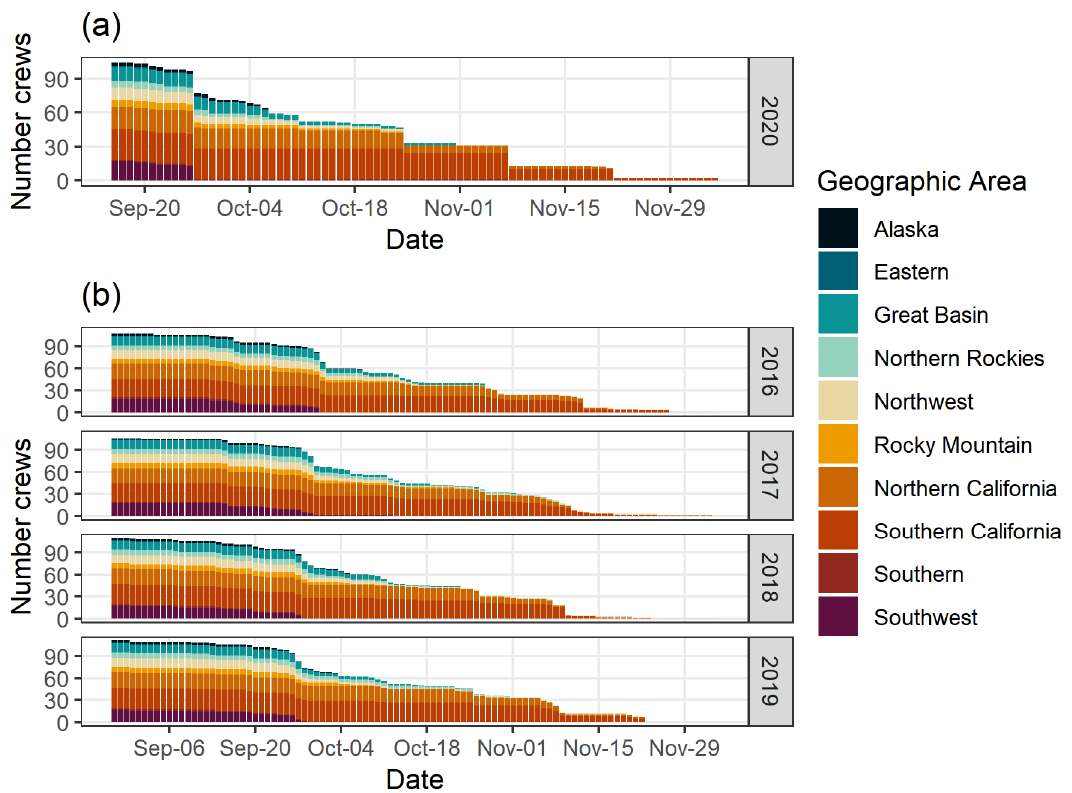
Figure 4. ( a ) The number of Interagency Hotshot Crews expected to be available for wildland fire assignments each day in the late season of 2020. Data collected manually by Shane Greer in 2020. ( b ) The number of hotshots available for wildland fire assignments each day in the late season of 2016, 2017, 2018, and 2019. Data aggregated by the Interagency Hotshot Steering Committee.